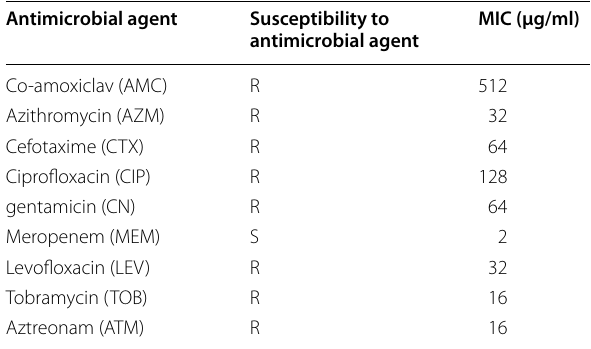
Table 2 Results of antibiotic susceptibility of the clinical